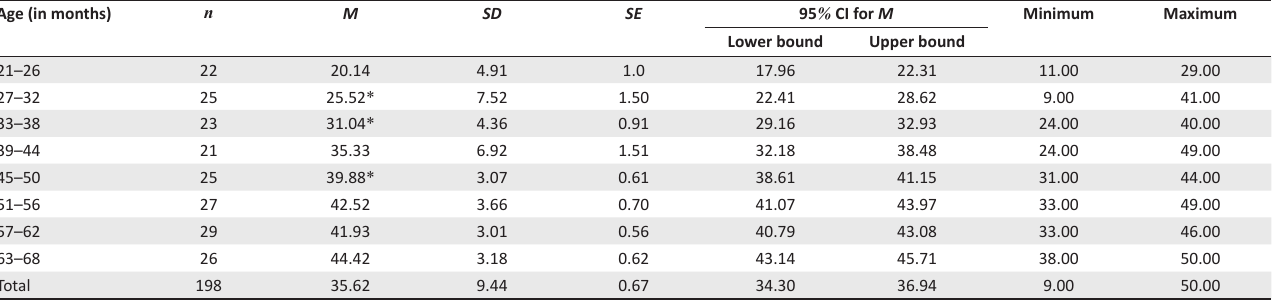
Lower bound Upper bound